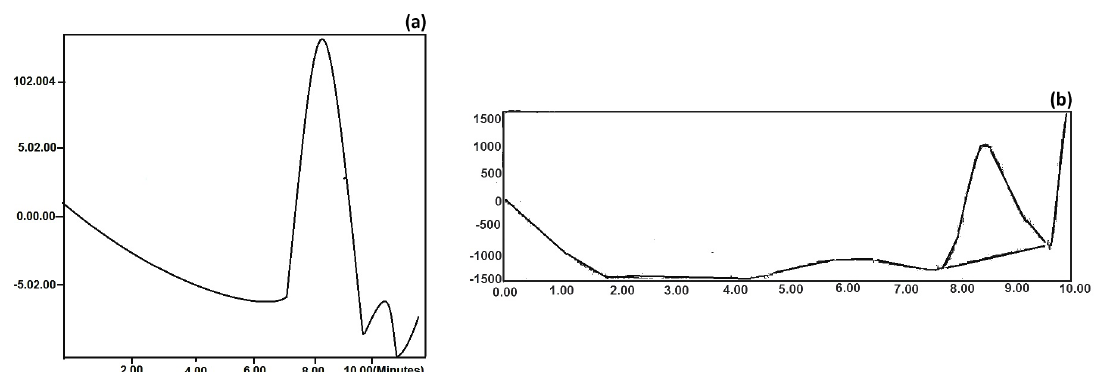
Fig.8a. GPC Thermogram of PBSeBT copolyester; b. GPC Thermogram of PBSBT